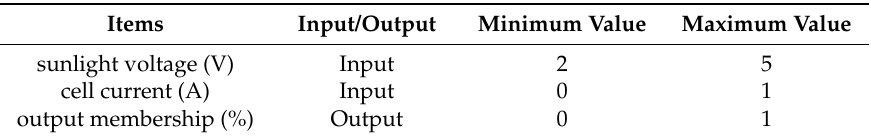
Table 3. Membership functions for the input variables.